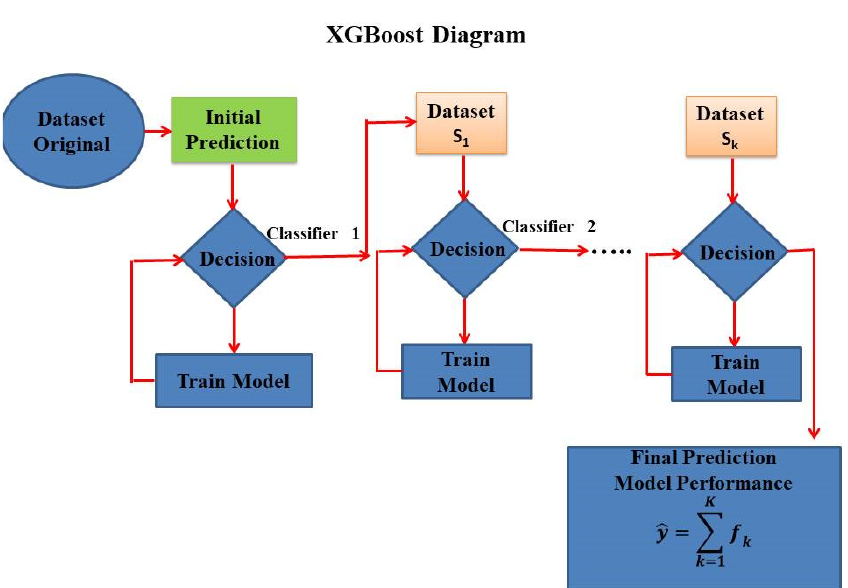
Figure 2. Schematic diagram of XG Boost.